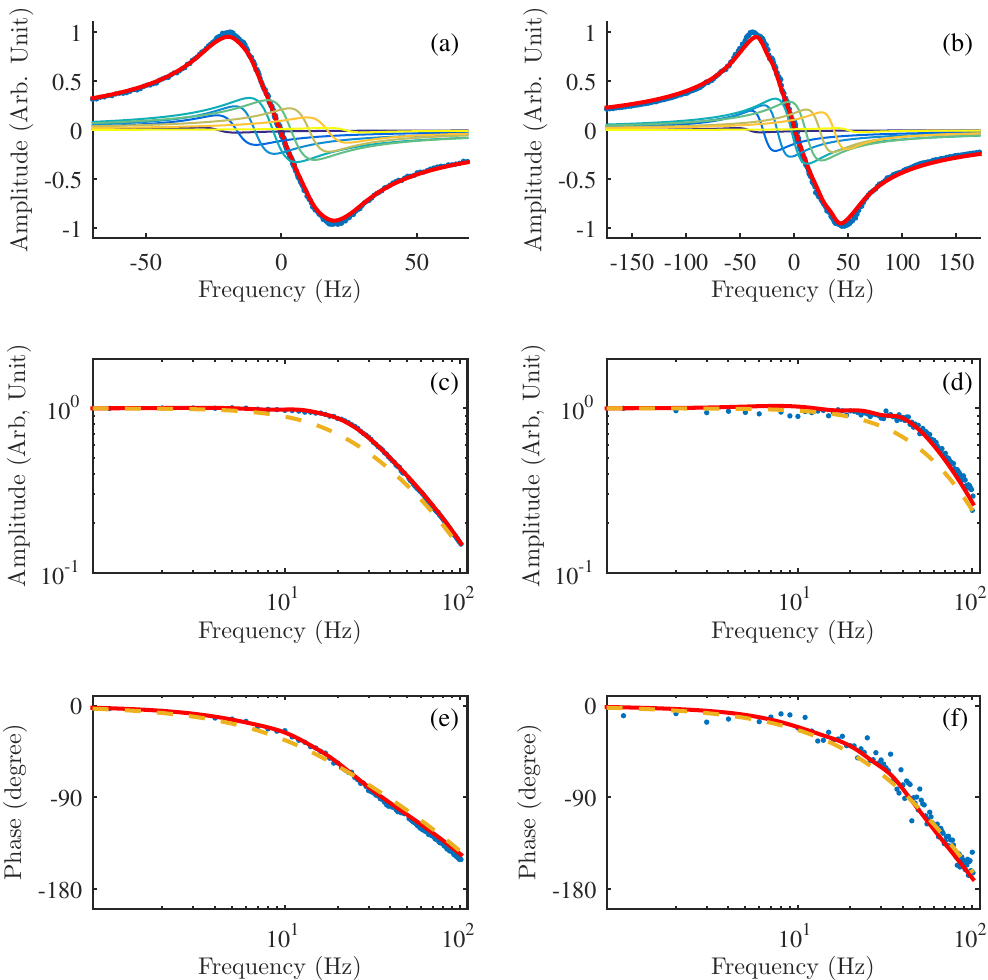
Figure 3. Magnetic resonances and frequency responses of the Bell–Bloom cesium OPM at a biasing magnetic field of 50 µ T and 70 µ T. The figures in the left column represent the results with 50 µ T biasing magnetic field while the figures in the right column represent the results with 70 µ T biasing magnetic field. The figures in the top, the middle, and the bottom panels correspond to the magnetic resonances, the amplitude-frequency responses, and phase-frequency responses, respectively. The blue dots are the experimental results and the red solid lines are the simulated results according to the model in this work. The eight fitted individual Lorentz curves are presented in the top panel. The yellow dashed lines in the middle and bottom panels are the simulated results according to the first-order Butterworth low-pass filter. Table 1. Fitted linewidth and amplitude of each Lorentz curve in the magnetic resonances of the Bell–Bloom cesium OPM at a biasing magnetic field of 50 µ T and 70 µ T. 50 µ Resonance No.